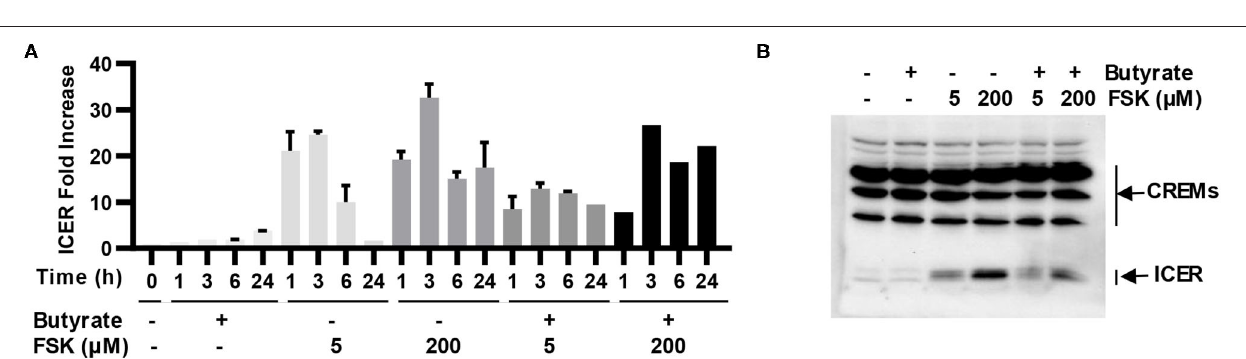
FIGURE 7 | Induction of inducible cAMP early repressor (ICER) in chicken macrophages in response to butyrate and FSK. (A) Chicken HD11 cells were treated with 2mM butyrate or two concentrations of FSK (5 and 200 µ M) individually or in combination for indicated times, followed by RT-qPCR analysis of ICER expression. Results are shown as means ± SEM of three independent experiments. (B) HD11 cells were treated with 2mM butyrate in the presence or absence of 5 or 200 µ M FSK for 6h, followed by Western blot analysis of ICER. Results are shown as a representative of two independent